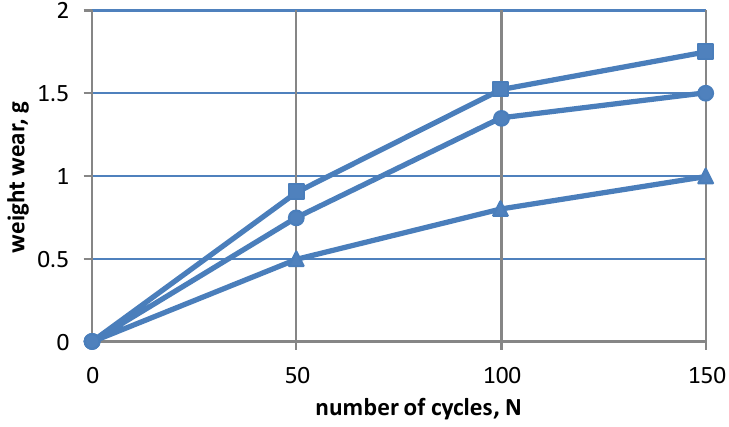
Fig. 3. Dependence of wear of coverings on duration of tests: ▲ - ASC P = 0.4 MPa; ● - ASC P = 0.8 MPa; ■ - AC = 0.4